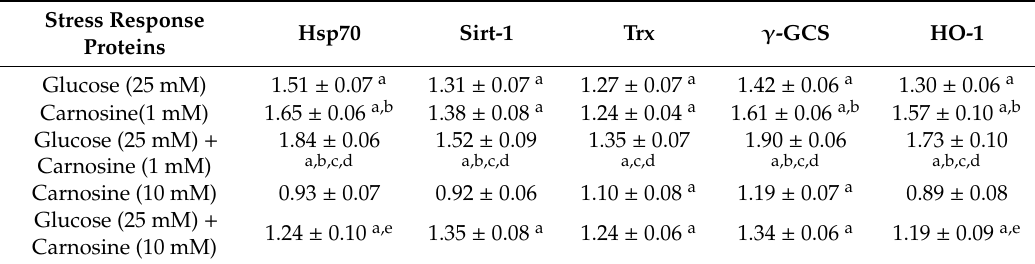
Figure 1. Cellular heat shock protein 70 (Hsp70) concentration (normalized to untreated cells) significantly increased in murine immortalized podocytes under glucose stress (25 mM; p = 3.7 × 10 − 7 ) or under carnosine addition (1 mM; p = 1.2 × 10 − 8 ). Co-incubation with carnosine (1 mM) and glucose (25 mM) induced further upregulation of Hsp70 protein concentrations compared to single treatment ( p = 4.7 × 10 − 3 vs. glucose and p = 0.001 vs. carnosine) or control ( p = 2.1 × 10 − 9 ), determined by western blotting ( A ) and quantified with an imaging software normalized to respective β -concentrations ( B ). Note: n = 5, a = significant increase vs. control, b = significant increase vs. glucose (25 mM), c = significant increase vs. carnosine (1 mM), d = significant increase vs. glucose (25 mM) + carnosine (10 mM), e = significant decreased vs. glucose (25 mM), *** p < 0.001. Table 1. Cellular stress response protein concentration. Cellular heat shock protein 70 (Hsp70), sirtuin-1 (Sirt-1), thioredoxin (Trx), gamma-glutamyl cysteine synthetase ( γ -GCS) and heme oxygenase-1 (HO-1) protein concentrations in podocytes treated with high glucose and carnosine (1 or 10 mM) alone or in combination. The derivatized proteins were separated by SDS / PAGE (see Figures 1–4), quantified and normalized to untreated